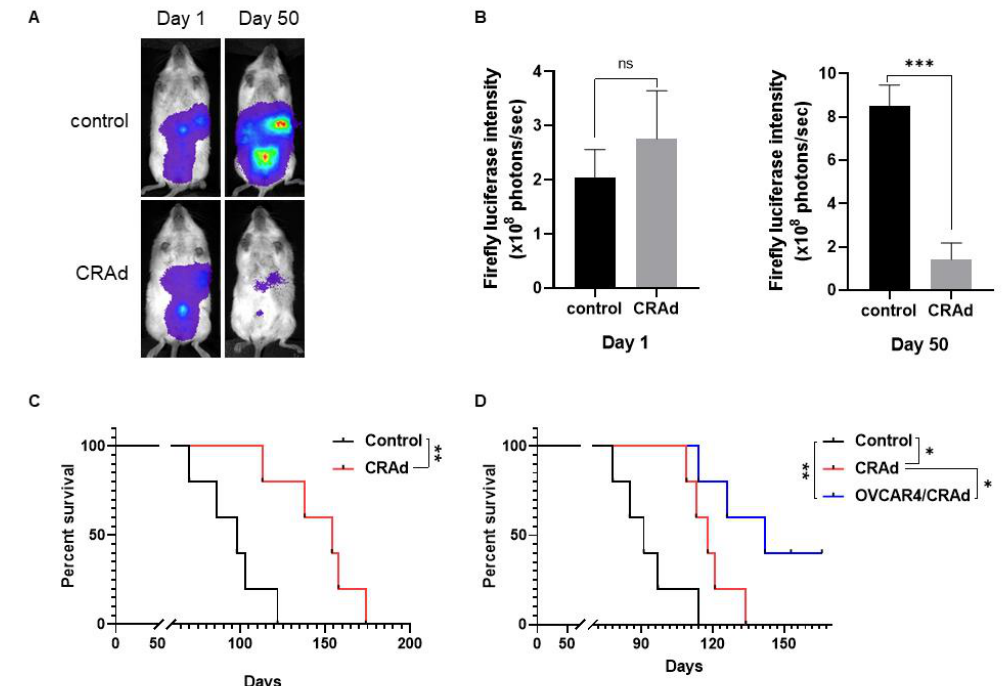
Figure 5. Oncolytic activity in ovarian cancer xenograft models using immunodeficient NSG mice. ( A ). Representative mouse in each group of the NSG/Kuramochi model imaged on day 1 and day 50. ( B ). Firefly luciferase intensity of NSG/Kuramochi groups on day 1 and day 50. *** p = 0.0004, CRAd group vs control group, ns, no statistical significance, n = 5. ( C ). Survival curve of NSG/Kuramochi model. ** p = 0.0097, n = 5. ( D ). Survival curve of NSG/OVCAR4 xenograft model with n = 5 in each group. * p = 0.0204, control vs. CRAd; ** p = 0.0028, control vs CRAd-infected cells, * p = 0.0326, CRAd vs CRAd-infected cells.